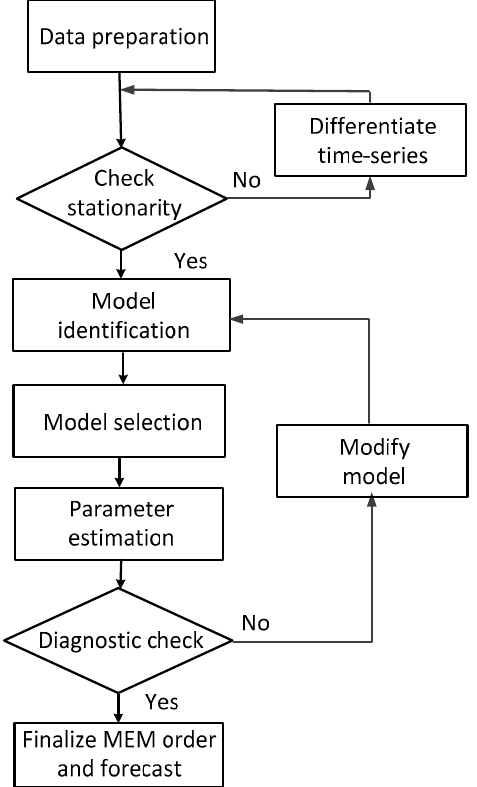
Figure 2. Flowchart for model identification, selection, and forecast.